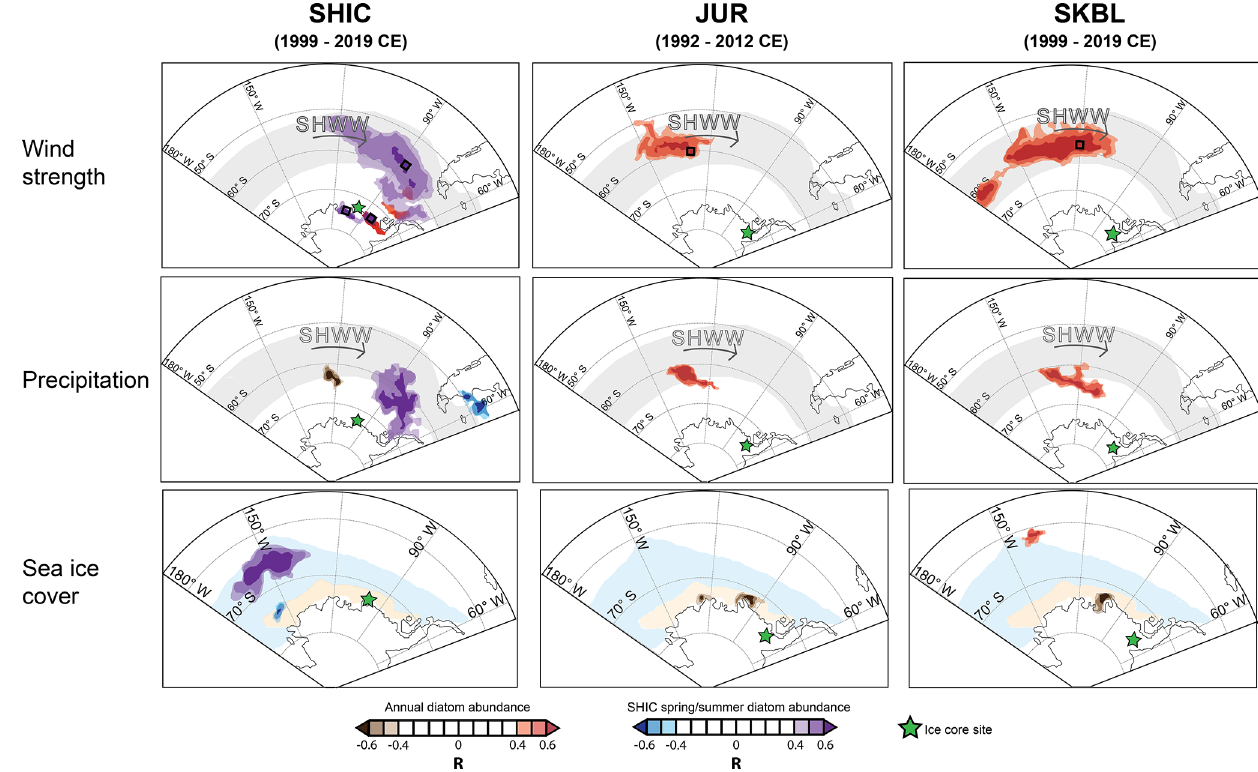
Figure 3. Regional maps showing spatial correlations between environmental parameters and diatom abundance. Colour-coded polygons in the maps indicate highly correlated regions ( R ≥ 0 . 45 or R ≤ − 0 . 45). All polygons plotted are statistically significant ( p < 0 . 05). The pale grey latitudinal band indicates the core of the Southern Hemisphere westerly wind (SHWW) belt. Pale blue polygons indicate the region covered by seasonal sea ice. Pale orange polygons indicate the region covered by perennial sea ice. Black squares represent a 1 ◦ × 1 ◦ quadrant around the point of highest correlation (QHC) between wind strength and diatom abundance. Regional maps only present areas of spatial correlation larger than 1 ◦ × 1 ◦ . Degrees of freedom (DF) for each spatial correlation can be obtained using the following expression dependent on the sample size ( n ): DF = n −